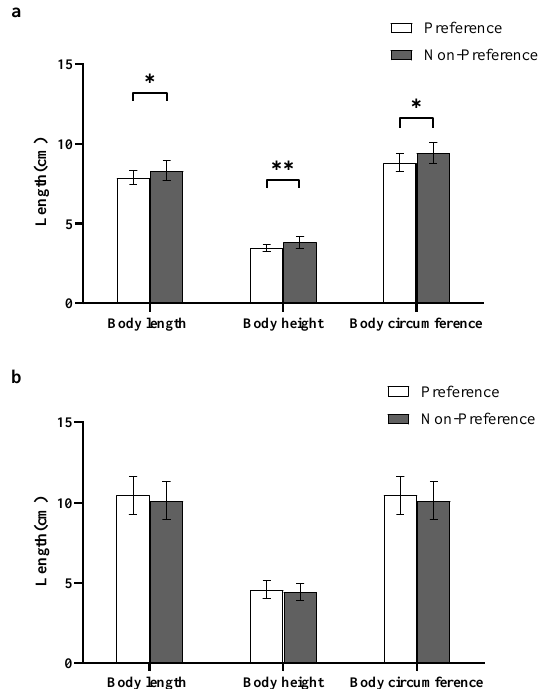
Figure 2. Body size preference for the different sexes. ( a ) Female body size preference in Experiment 1; ( b ) Male body size preference in Experiment 2. A significant difference is denoted by an